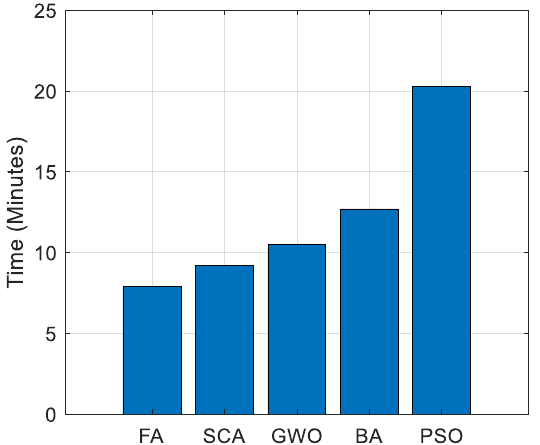
Figure 17. Comparison of execution time.